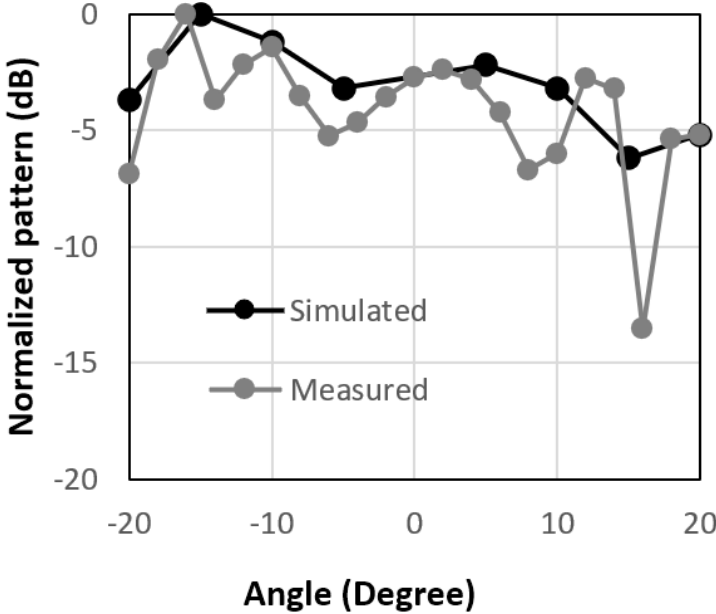
Figure 8. Normalized radiation patterns for combined-type of unit cells at 3.5 GHz.